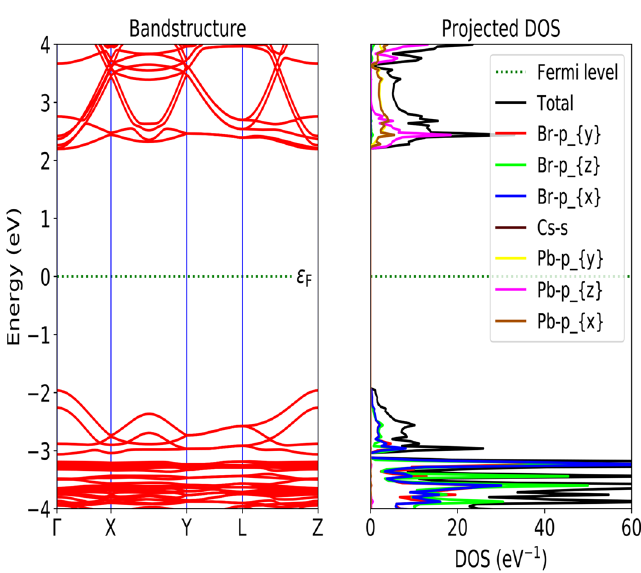
Figure 4. Band structure and density of states (DOS) of 001-surface of CrPbBr 3 calculated from